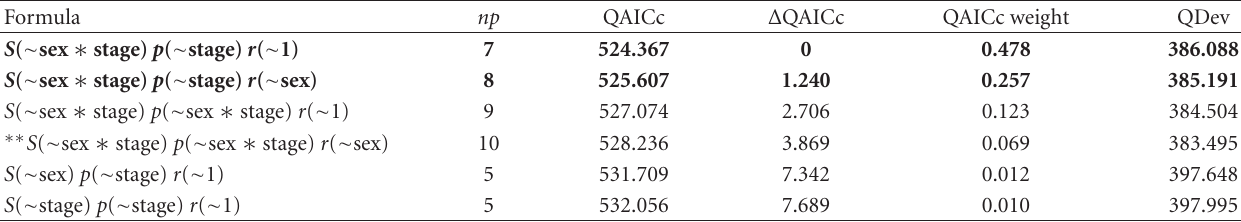
Table 1: Model selection (two-stage models) for survival ( S ), resighting probability ( p ), and recovery probability ( r ) with the site fidelity ( F ) of the otters set to 1. For each model the corrected quasi likelihood Akaike’s information criterion (QAICc), the di ff erence in QAICc between the current model and the best fitting model ( Δ QAICc), the number of estimable parameters ( np ), their weight (QIACc weight), and deviance (Qdev) are given. Fitted models are sorted by increasing QAICc, the first being the one that best represents the data. We present here only those models for which QAICc weight was greater than 0.01. These results are obtained after adjusting for overdispersion with (cid:2) c = 1 . 338. Formula np QAICc